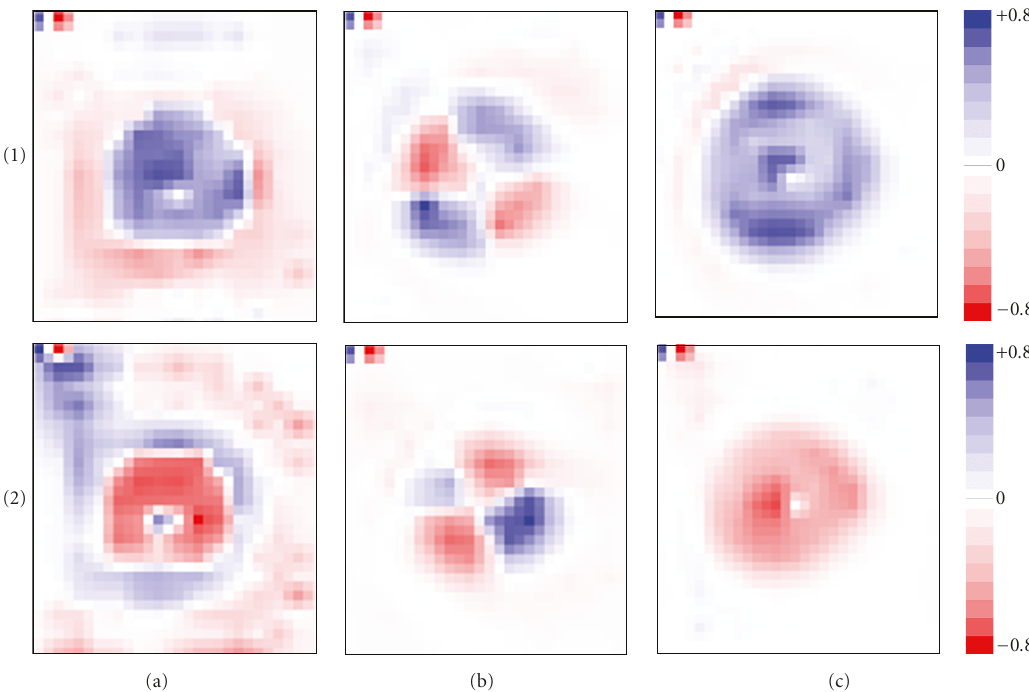
Figure 4: Velocity images of a normal subject in a slice from the midcavity portion of the LV. Line 1 presents diastolic images and line 2 presents systolic images. Column (a) depicts the images of the radial component. The several tones of blue in the myocardium in Line 1 represent the expansion while the tones of red in the same region in Line 2 represent the contraction. Column (b) presents the images of the horizontal rotation component. The tones of blue represent counterclockwise rotation while the tones of red represent clockwise rotation. Column (c) presents the images of the vertical component. The tones of blue represent downward motion while the tones of red represent upward motion. The color scale is shown at the top right of the